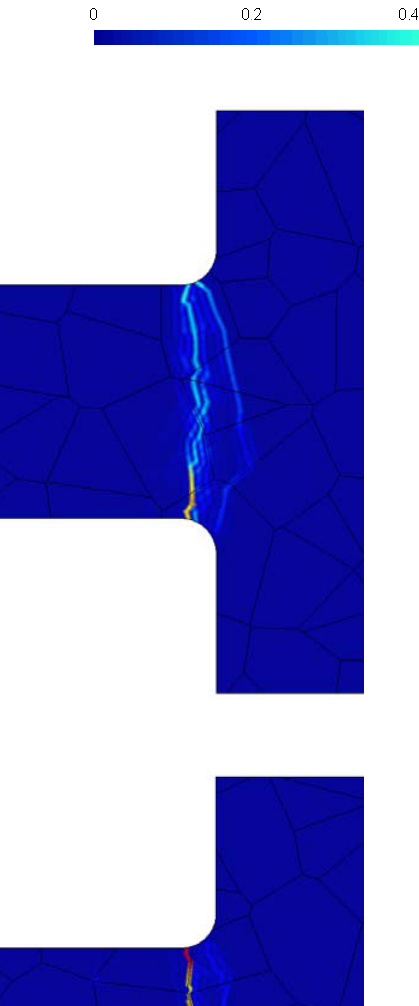
 M t GPa, 5.2  M t GPa); G GB  M t GPa, 0.2  M t G GB